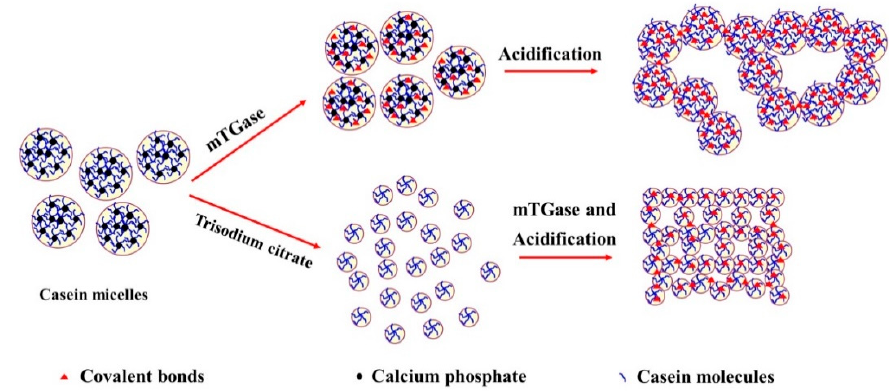
Figure 3. The schematic representation of the role of trisodium citrate in the formation of acid-induced, transglutaminase-treated casein gels.